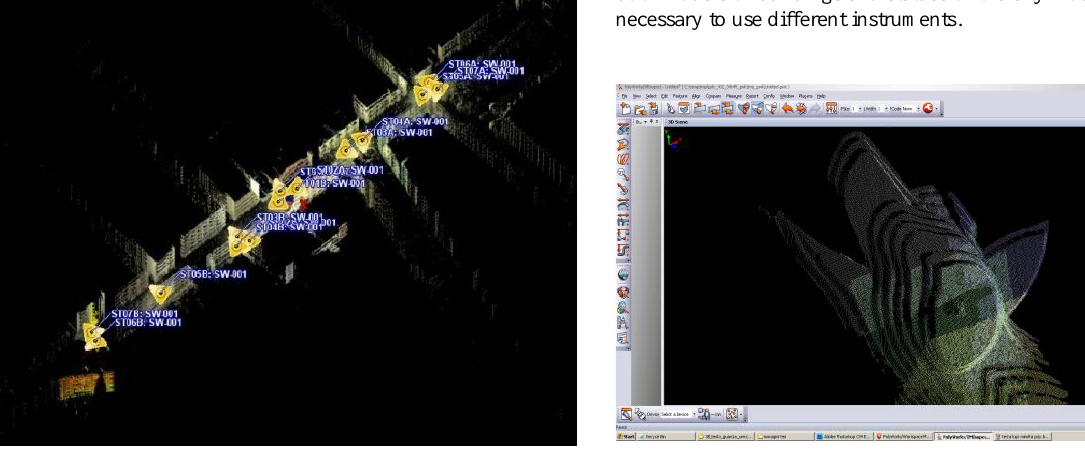
Figure 2. The layout of the TOF Laser Scanner Survey.